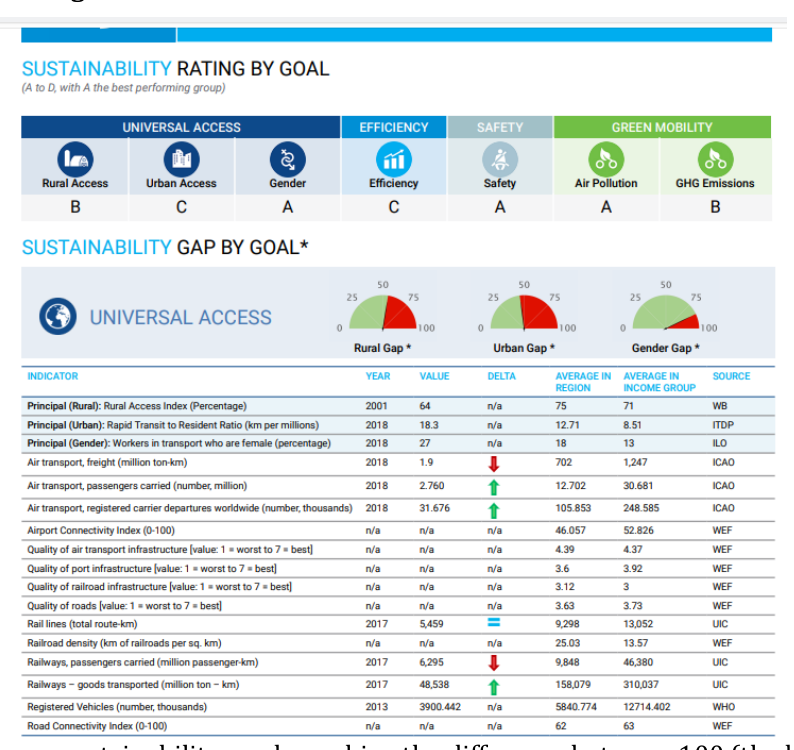
Figure 2: Universal Access Indicator Values for Belarus